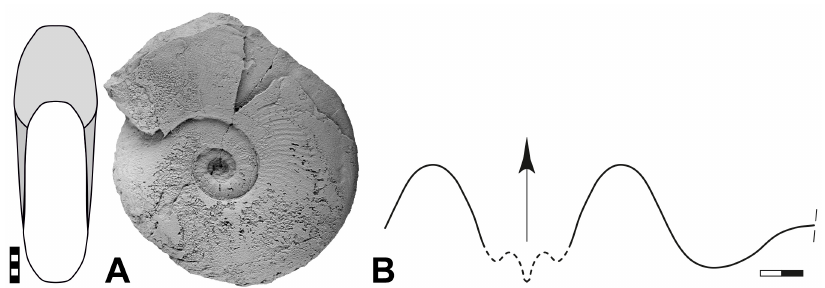
Fig. 7. Pseudoprobeloceras applanatum (Wedekind, 1918). Specimen MB.C.22157 (Koch Coll.) from Oberscheld (Volpertseiche Mine). A . Lateral view and dorsal projection. B . Suture line, at ww = 11.8 mm. Scale bar units = 1 mm.